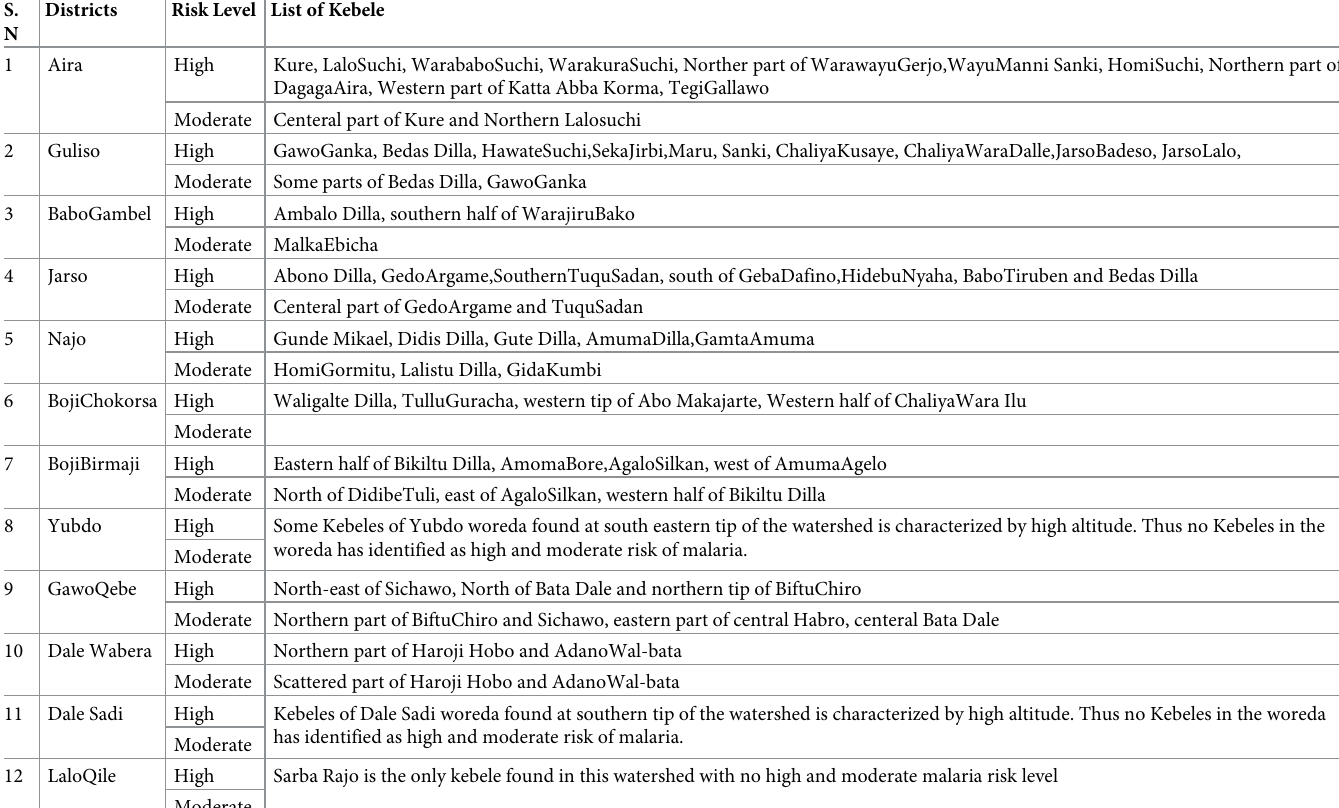
Table 4. Malaria risk level of Dilla watershed in districts and kebele. S.